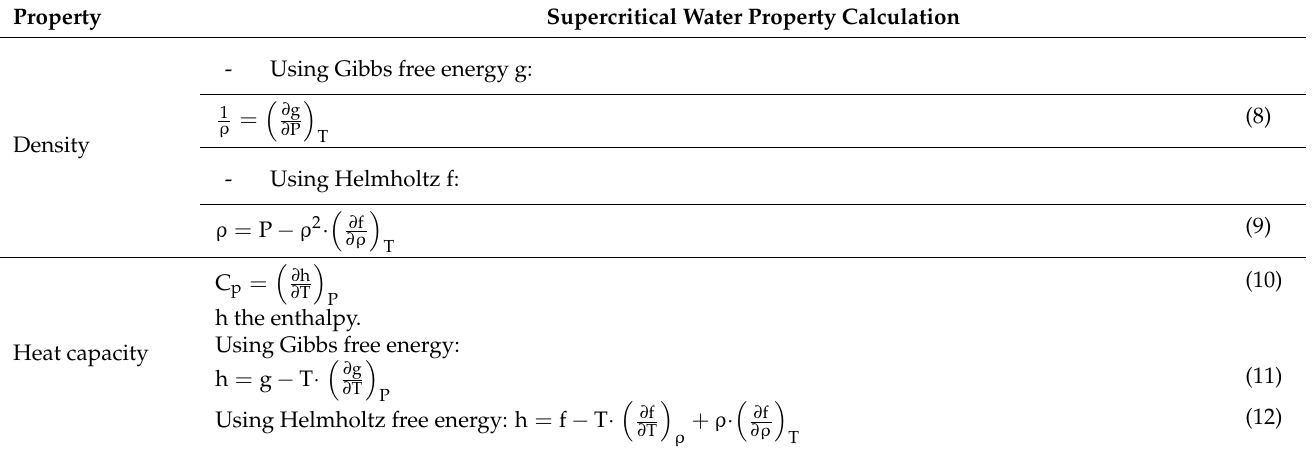
Table 2. Equations of supercritical water property